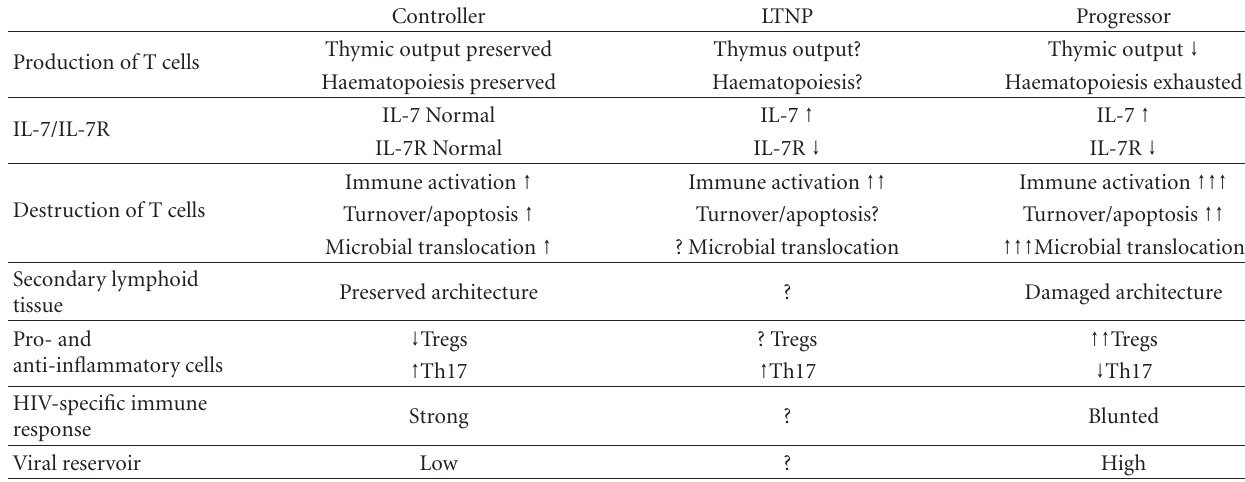
Table 2: Immunological distinctions between progressors and